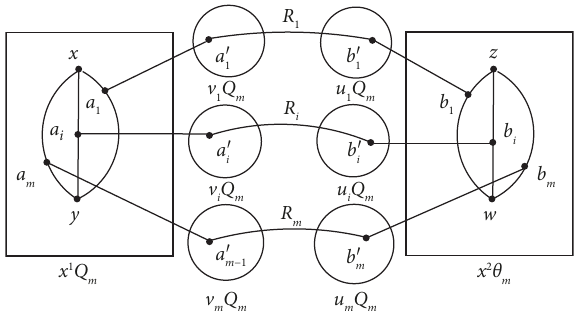
Figure 13: Te illustration of subcase 2.2 of Teorem 2.